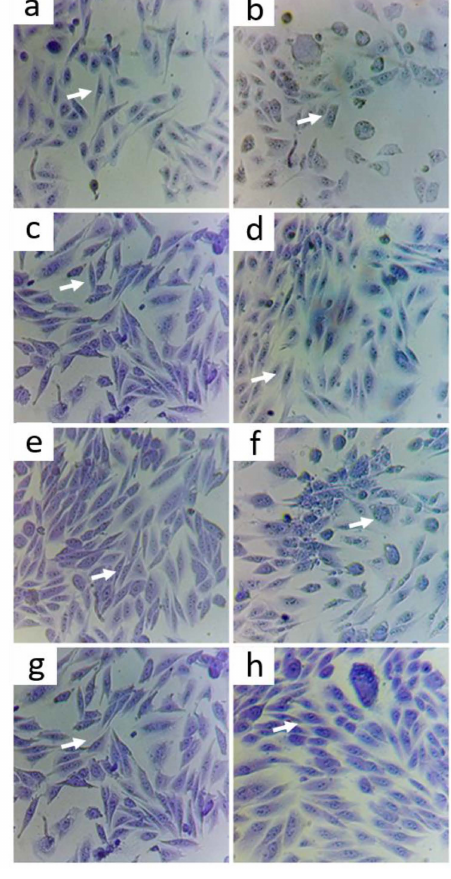
Figure 5. Violet crystal staining to determine viability in cells treated for 2 h with 0.5 mg/mL CoQ10, 0.05 mg/mL Zn, and 0.5 mg/mL CoQ10 + 0.05 mg/mL Zn compared with that seen with the same treat- ments in the presence of As at 5 ppm. ( a ) control, ( b ) As, ( c ) CoQ10, ( d ) CoQ10 + As, ( e ) Zn, ( f ) Zn + As, ( g ) CoQ10 + Zn, ( h ) CoQ10 + Zn + As. Image taken with a camera under a 200 × optical